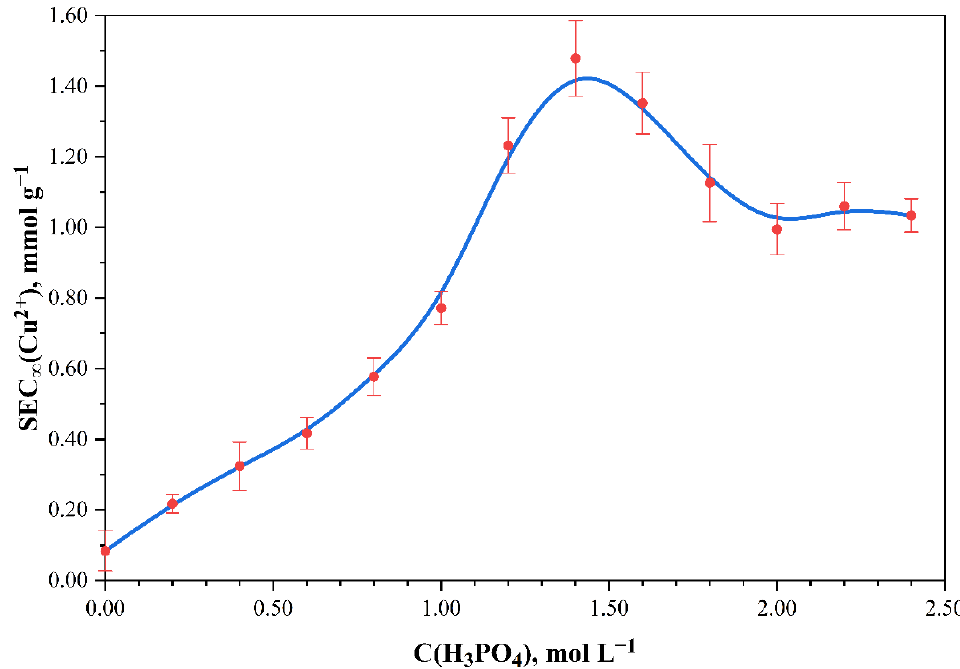
Figure 5. Effect of phosphoric acid concentration on the maximum static exchange capacity SEC ∞ (t = 20 °C) of phosphorylated cotton cellulose samples related to Cu 2+ .